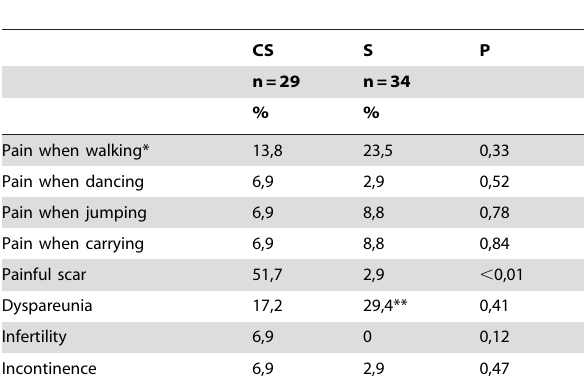
Table 2. Comparison of current complaints after CS and after